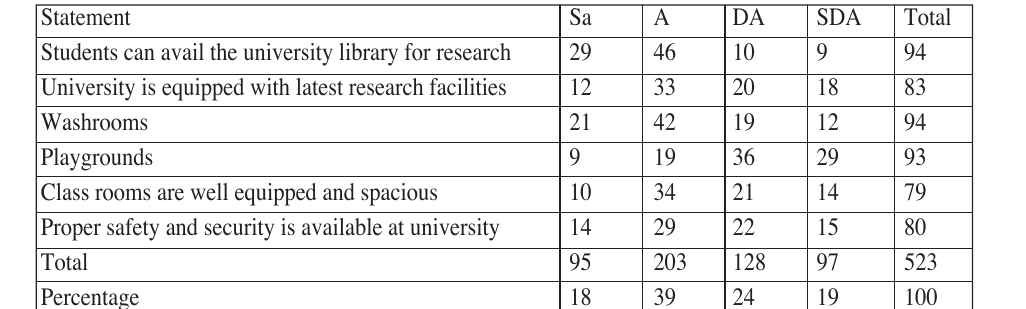
Table No. 5: Infrastructure Contribution To maintain the Quality in Higher Education